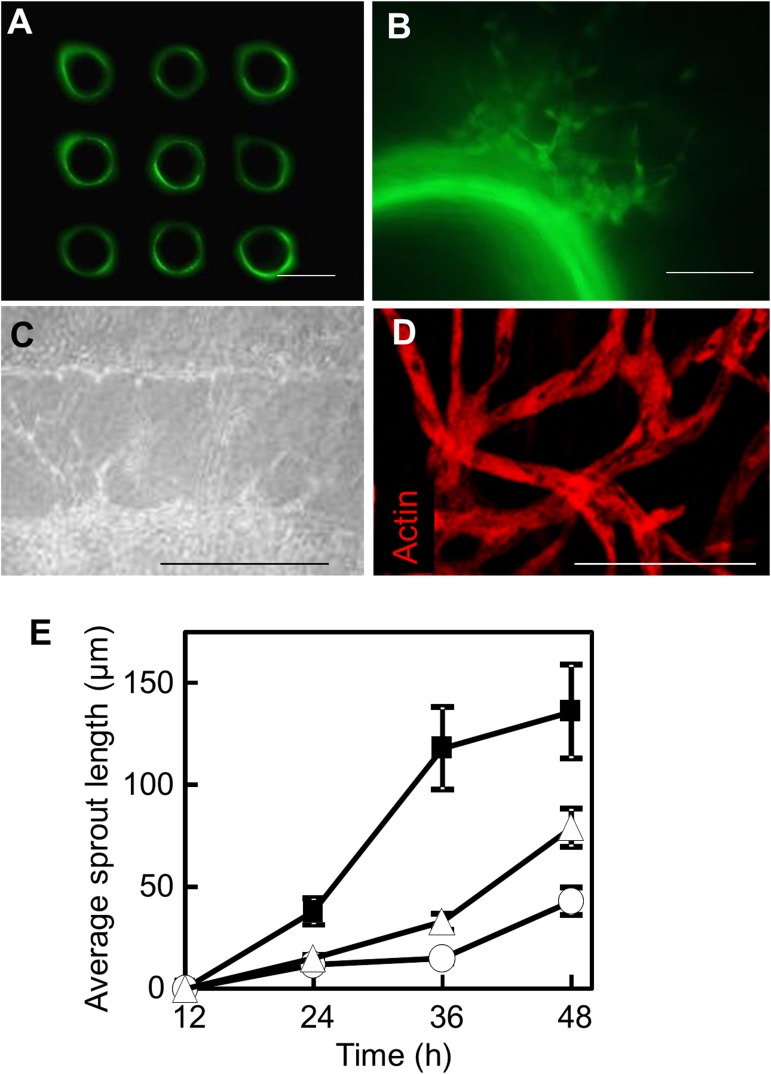
Synergistic effects of PMA and perfusion on endothelial cell sprouting.(A) Cross-sections of 3D-aligned HUVEC-enveloped microchannels. GFP-HUVECs were transferred to the internal surfaces by using the multi-needle. (B) HUVEC sprouting after 48 h of culture under perfusion at 10 μL/min and 50 ng/mL PMA. (C) Sprouts extended toward neighboring microchannels and bridged them after as few as 7 d. (D) Confocal microscopy image of luminal structures. (E) Quantification of the sprout length. Static culture in the absence of PMA (○), perfusion culture in the absence of PMA (Δ), and perfusion culture in the presence of PMA (■). Error bars indicate standard deviations calculated from three independent experiments. Scale bars indicate 500 μm in (A, C), and 100 μm in (B, D).